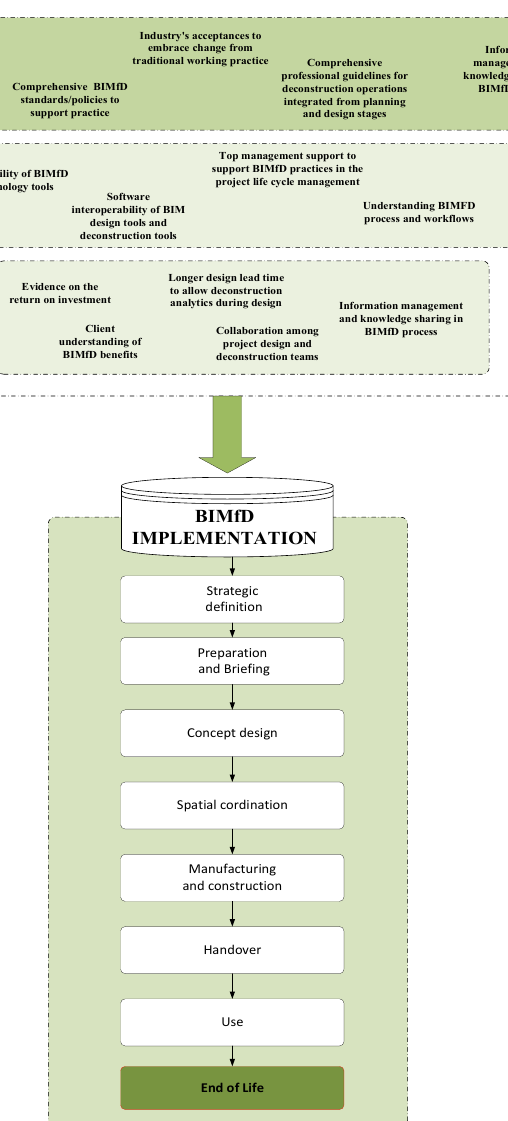
Figure 4. Conceptualised BIMfD implementation framework .